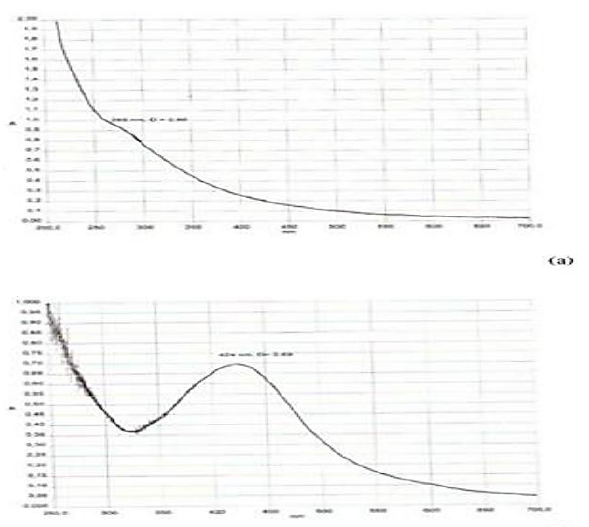
Figure 2. UV-Vis spectra of (a). HA in sodium hydroxide solution and (b). HA matrix contains Ag